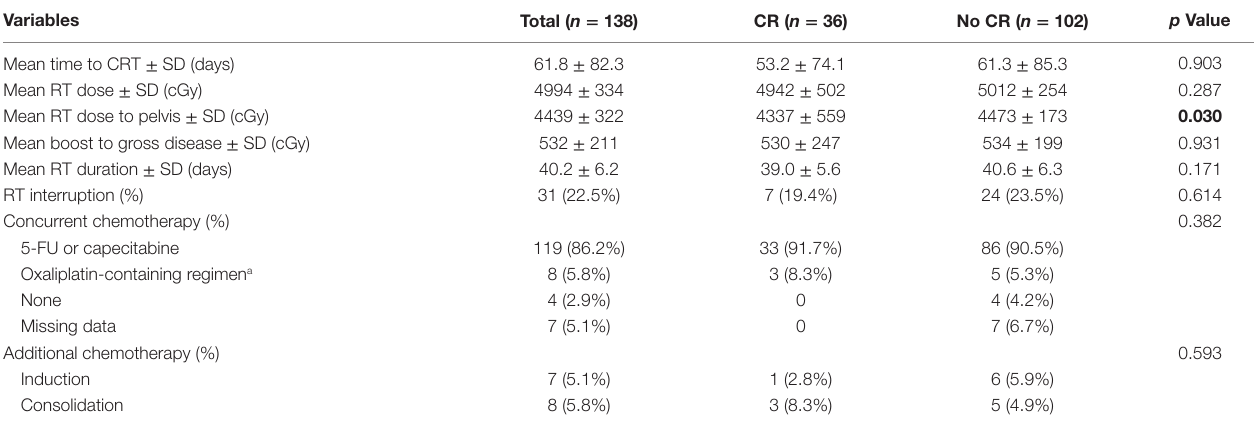
TaBle 2 | characteristics of